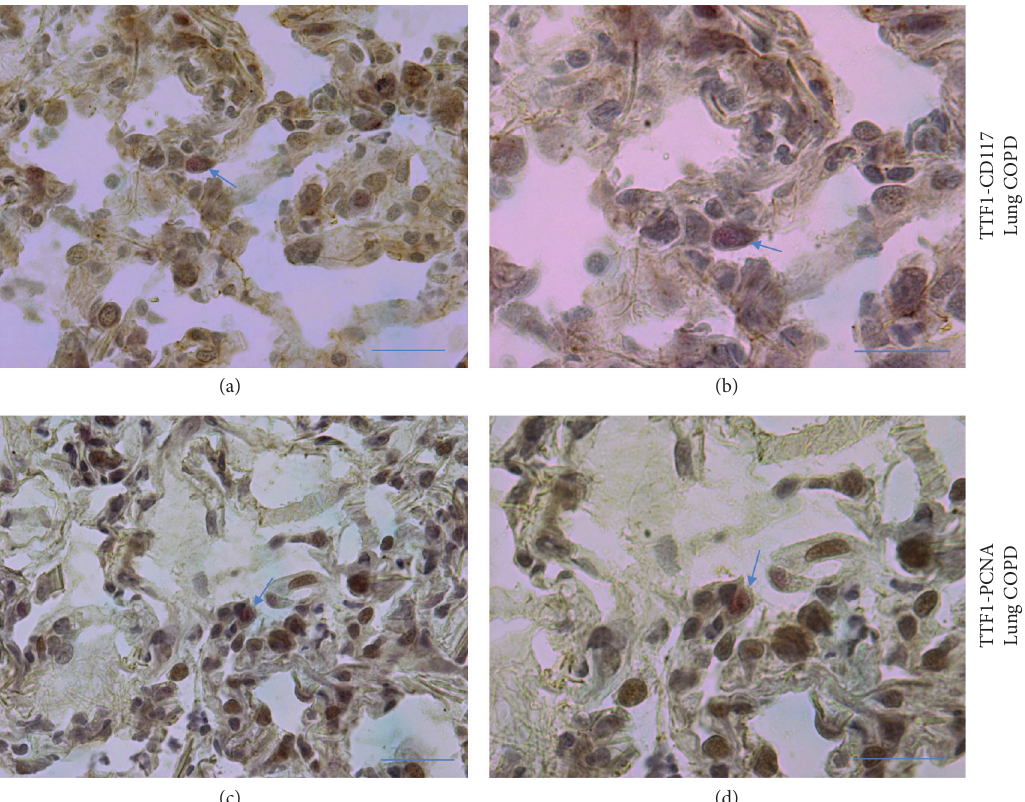
Figure 9: Photomicrographs showing alveolar type II epithelial cells (TTF-1+ cells, red color) coexpressing c-Kit (CD117) (brown color) (a, b) and PCNA (brown color) (c, d) in the peripheral lung tissue of a representative patient with COPD. Positive double-stained cells can be recognized in the alveolar septa, even though their presence was only rarely observed. Arrows indicate positively stained cells located in the alveolar septa. Bars � 50